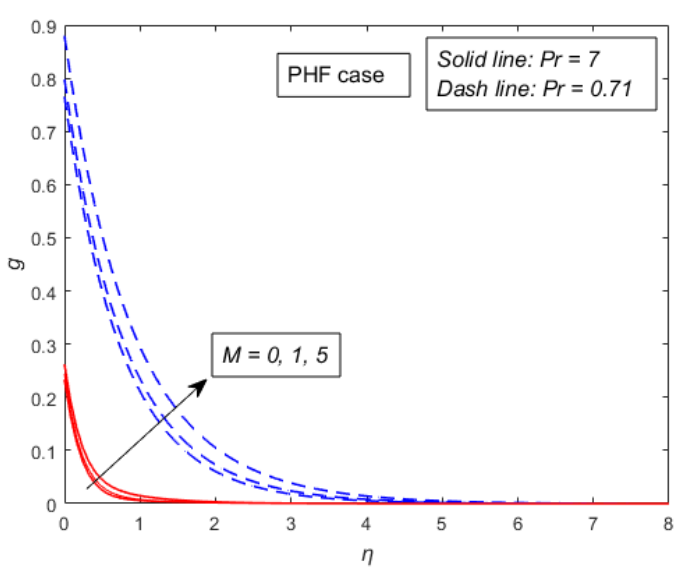
Figure 9. Variation of the temperature profile for different values of magnetic parameter M and Prandtl number Pr for the PHF case when n = 3, K = 1, and Ec = 0.1.